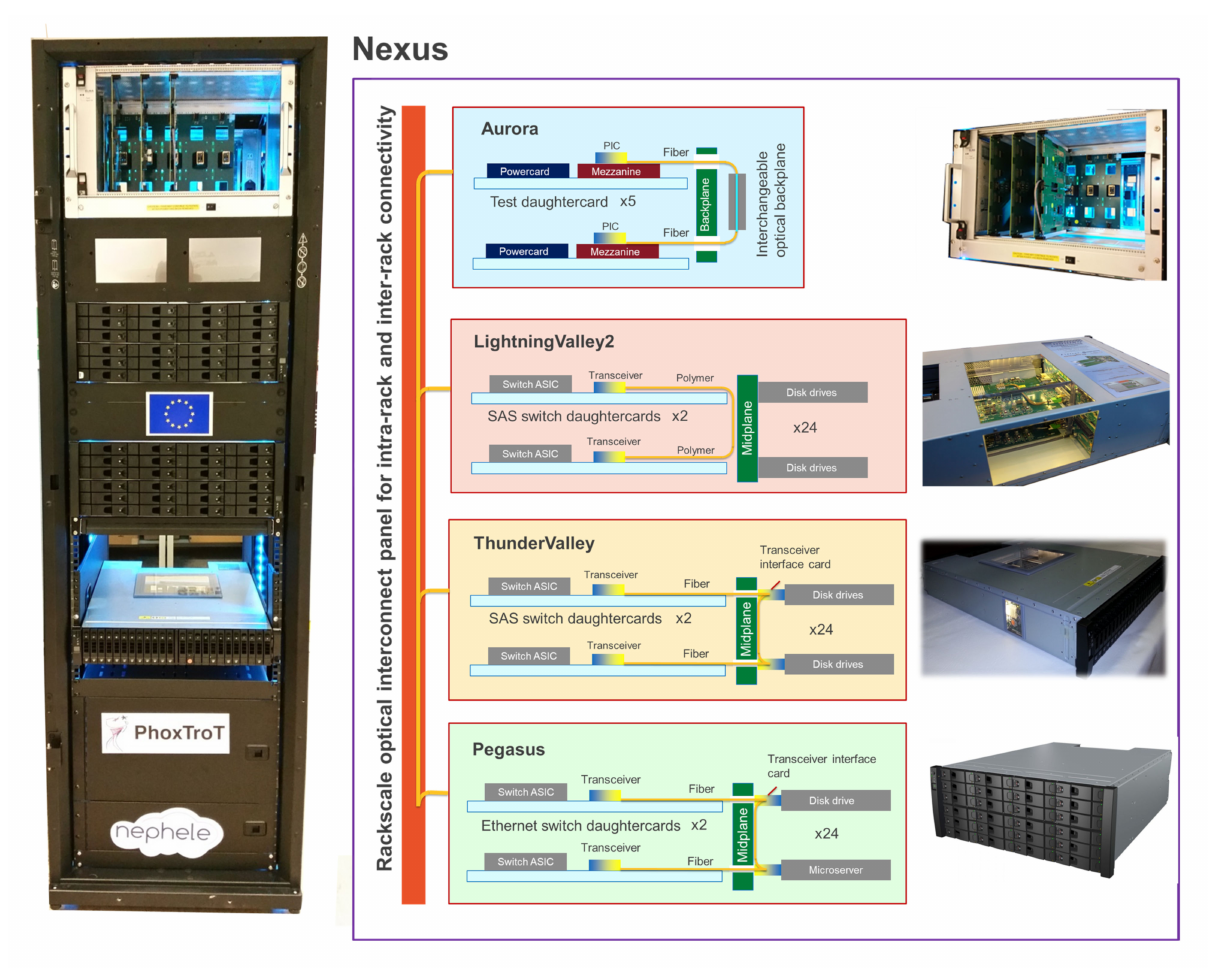
Figure 1. Schematic view of three optically enabled data center platforms (LightningValley2, Thun- derValley and Pegasus) and the Aurora test and measurement platform contained within the Nexus rack [7,8], which allows intra-rack and inter-rack connectivity between different